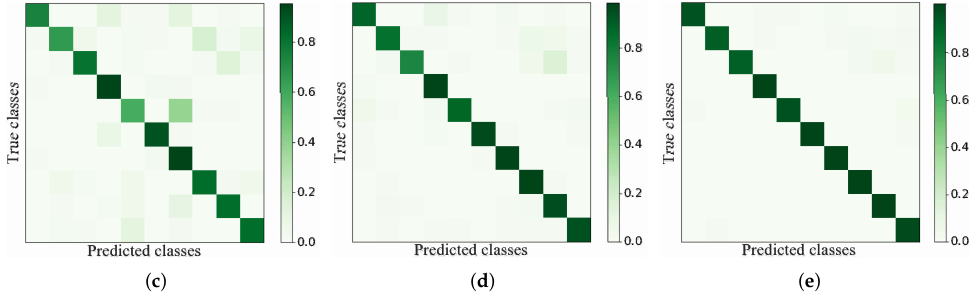
Figure 8. Comparison of confusion matrices under three methods while the experiment is carried out under the condition of 5-phase incremental learning. ( a ) iCaRL-NME. ( b ) United-NME. ( c )